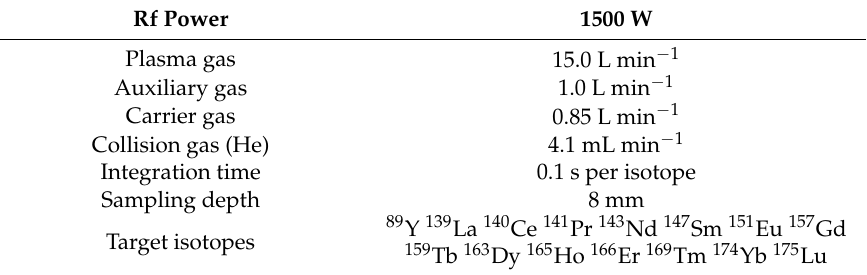
Table 4. Typical ICP-MS operating